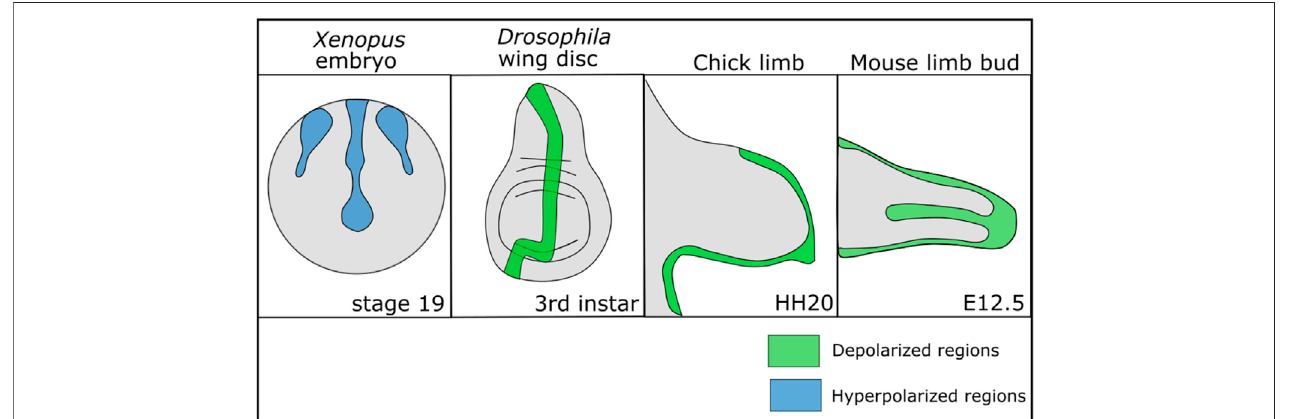
FIGURE 1 | Patterns of depolarization and hyperpolarization across various developing tissues. Developing Xenopus embryos have patterns of hyperpolarization acrosstheectoderm duringneurulation(Vandenberget al.,2011;Adamset al.,2016).In Drosophilamelanogaster ,thedeveloping wingdiscat thethirdinstarstagehas a stripe of depolarized cells along the anterior posterior boundary (Emmons-Bell and Hariharan, 2021). In developing chick and mouse limbs the mesenchyme is depolarized during chondrogenic differentiation (Atsuta et al., 2019).